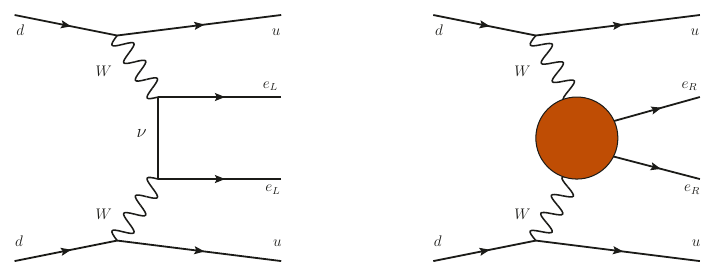
Figure 10 . Contributions to the neutrinoless double (cid:12) -decay process. Left: light neutrino exchange (long-distance contribution), proportional to m (cid:23) . Right: short-distance contribution proportional ee to (cid:15) 3 . The solid red blob corresponds to the e(cid:11)ective operator. O 9 panel of (cid:12)gure 10, which does not su(cid:11)er from the extra loop and ( m ‘ =v ) 2 suppression that e a(cid:11)ects the m (cid:23) neutrino mass entry, will largely dominate the neutrinoless double (cid:12) -decay ee amplitude [6,